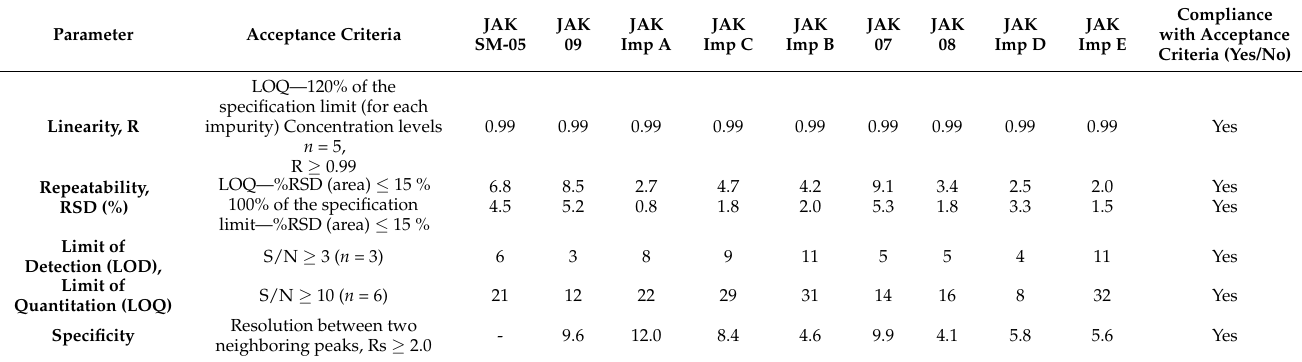
Table 6. Summary of the validation